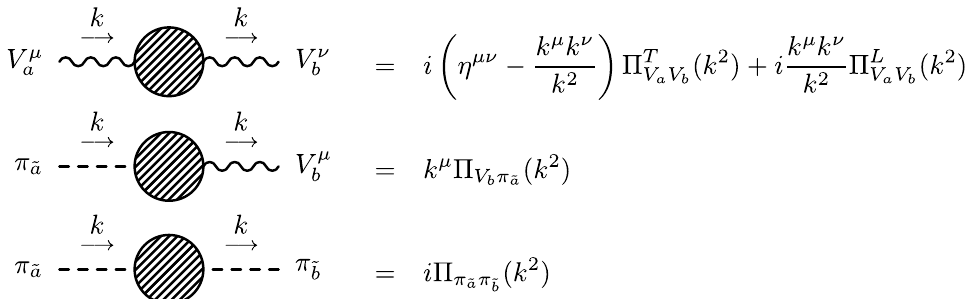
Figure 4: Diagrammatic definition of the 1PI amplitudes. The arrow denotes momentum